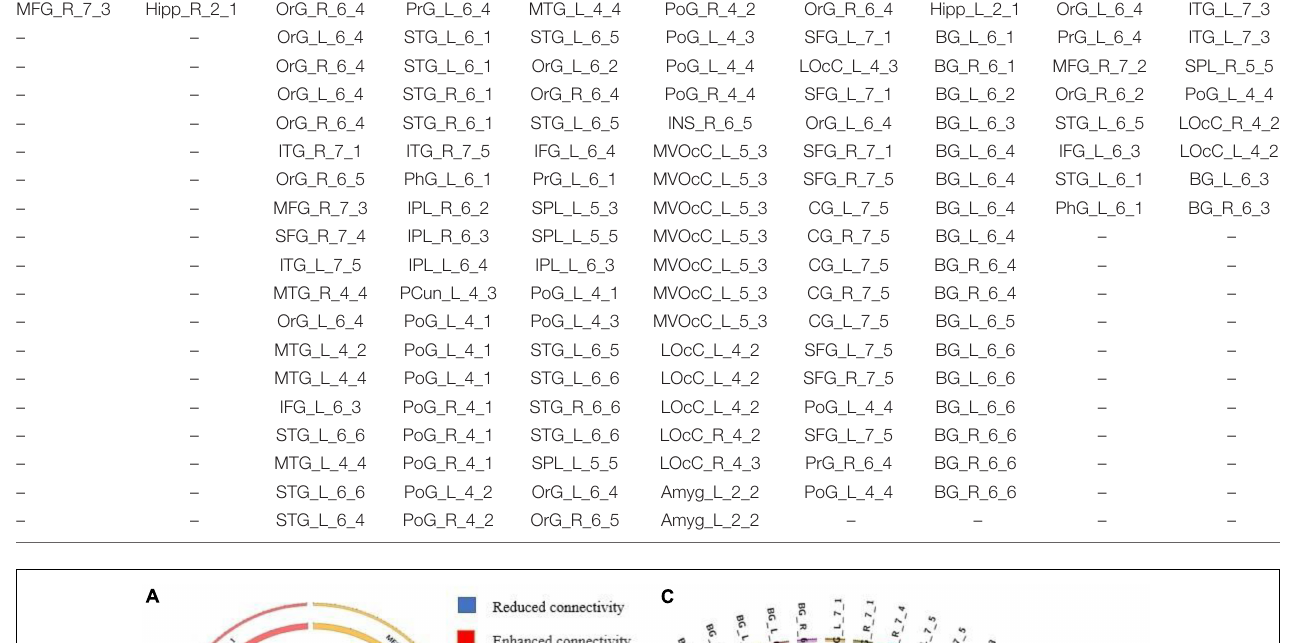
TABLE 2 | Differences in static functional connectivity without global signal regression. AVHs and non-AVHs AVHs and NC Region 1